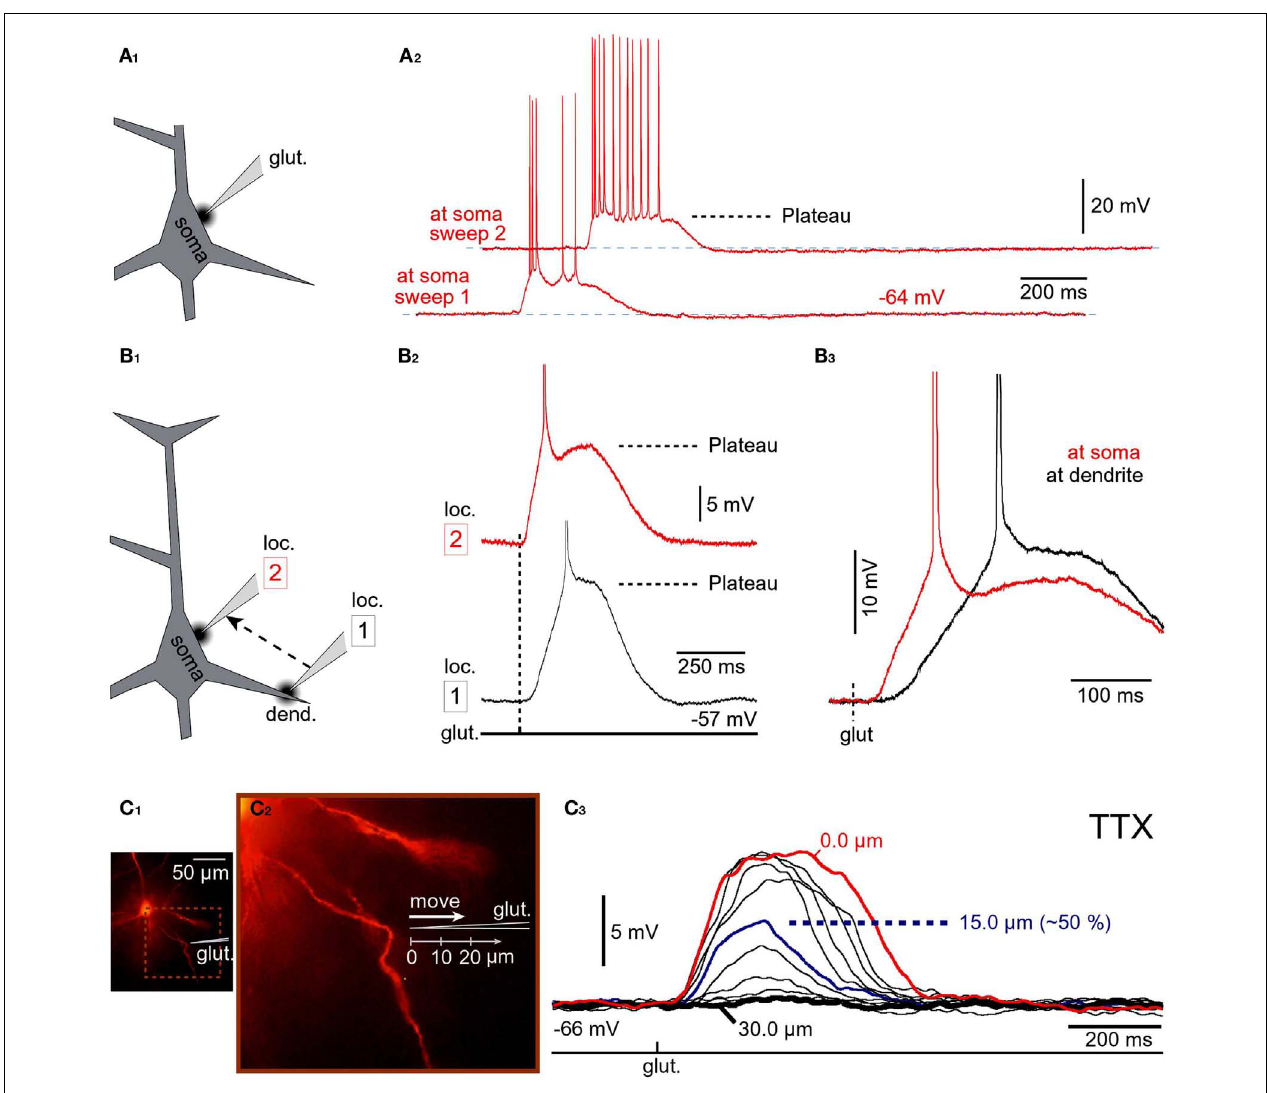
unchanged. (B 3 ) Same traces as in (B 2 ) except superimposed on fast time scale.